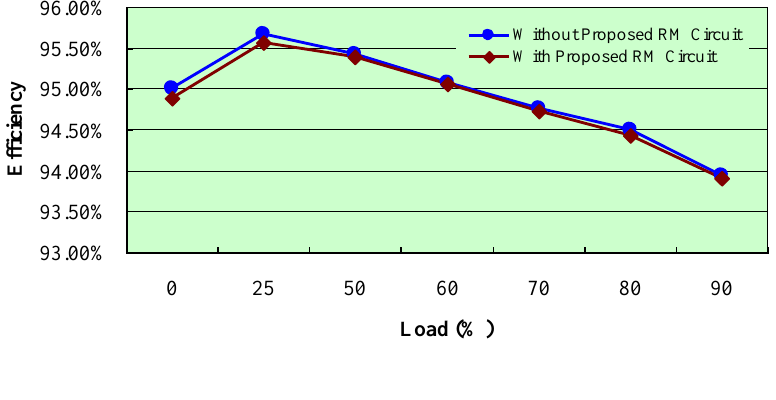
Figure 18. Efficiency comparison for the constructed experiment prototype with and without the proposed RM